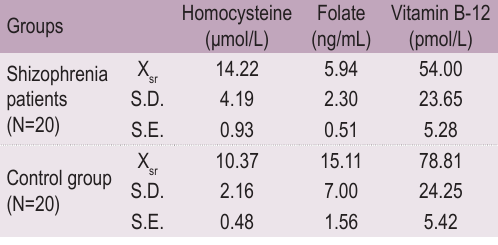
TABLE 1. The mean concentration of homocysteine, folate and vitamin B-12 in shizophrenia patients and control group.